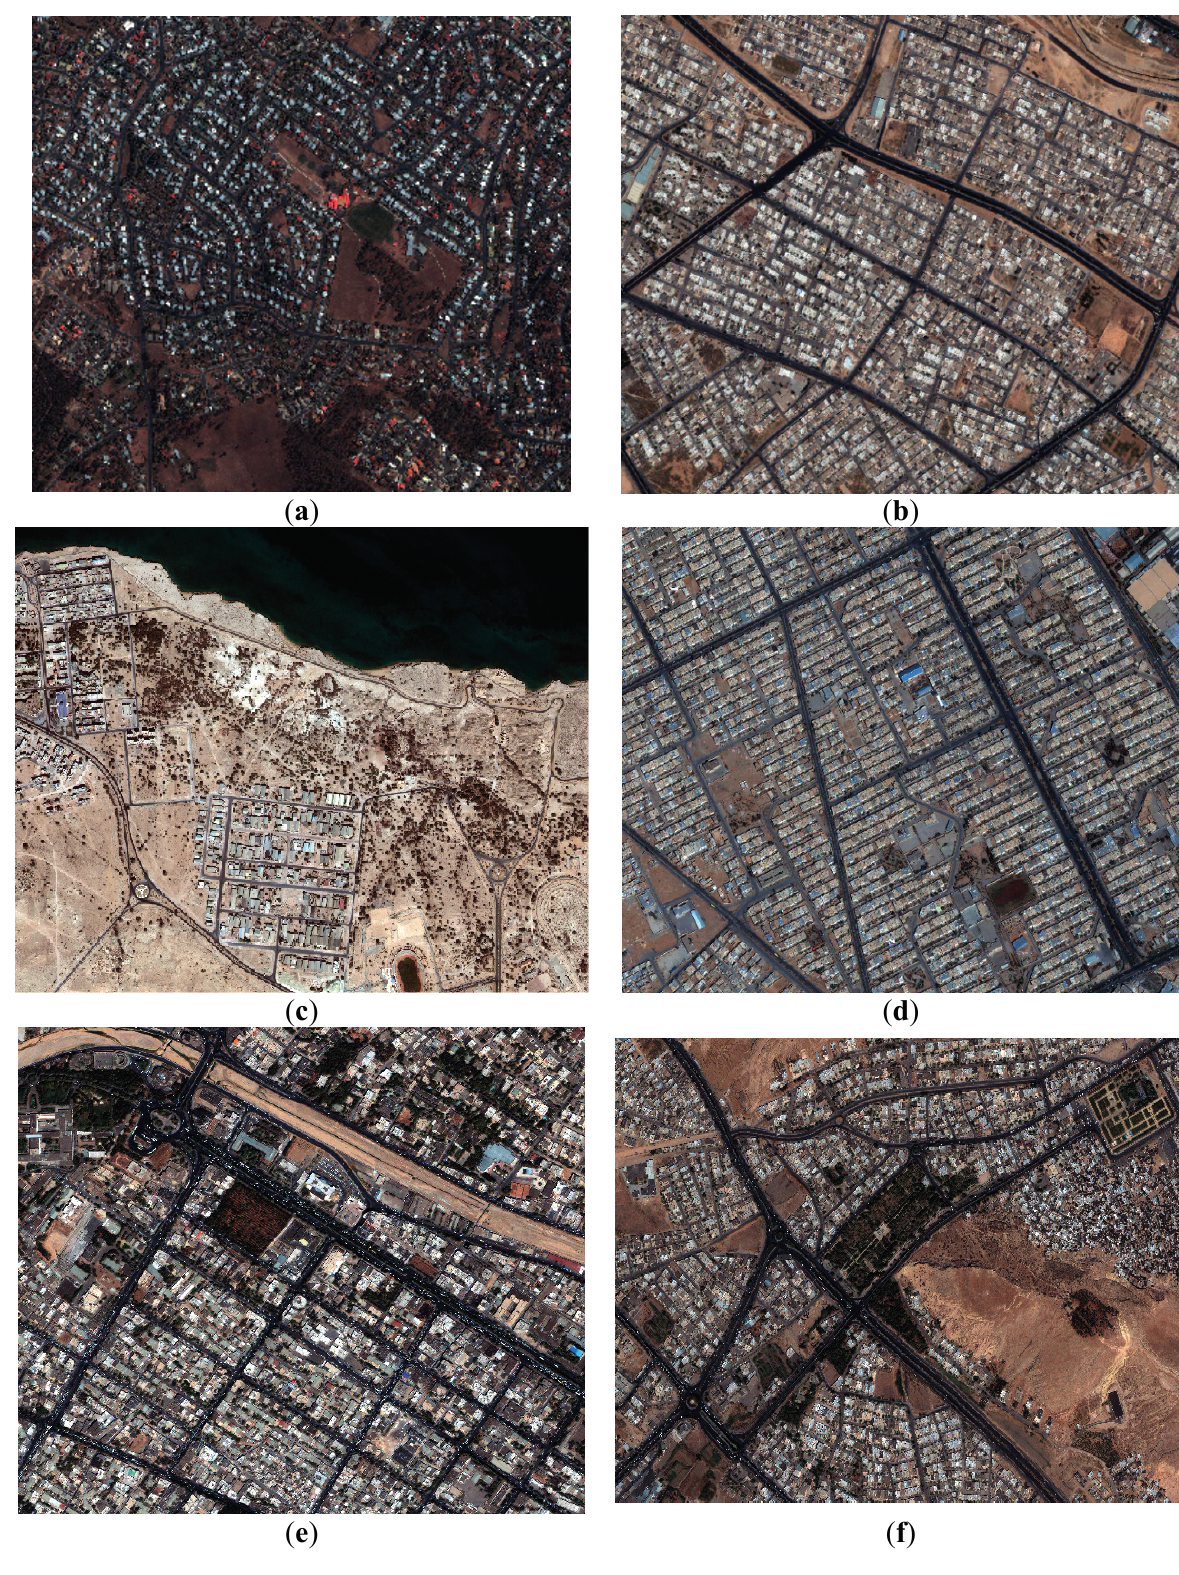
Figure 7. The IKONOS images: ( a ) Taken from Hobart in Australia; ( b ) Taken from Hamedan in Iran; ( c ) Taken from Kish Island in Iran; ( d ) Taken from Yazd in Iran; ( e ) Taken from Hamedan in Iran; ( f ) Taken from Shiraz in